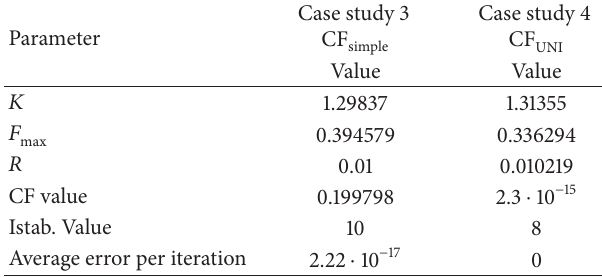
Table 7: Characteristics of the best solution: joined case studies 3 and 4, delayed logistic as CPRNG/controlled system.